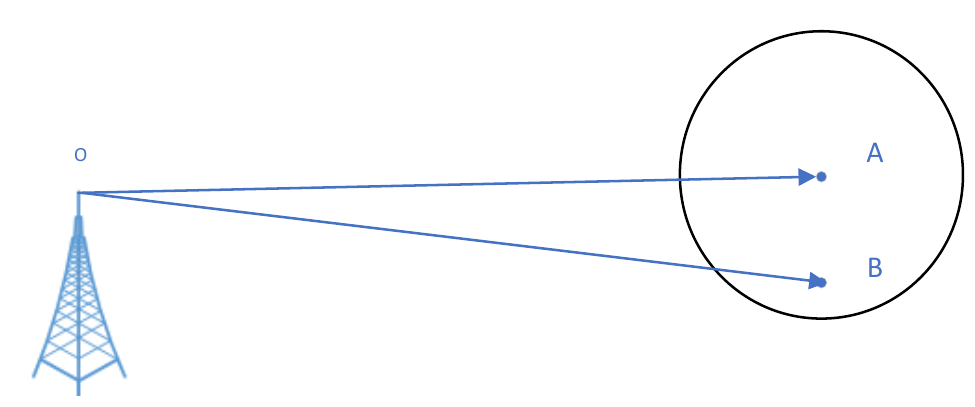
Figure 4. Diagram of difference station and surrounding users.